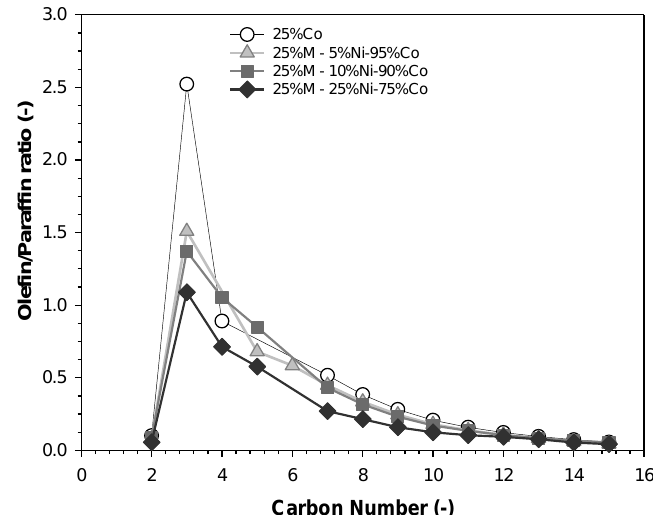
Figure 22. Olefin / para ffi n ratio at T.o.S. ≈ 150 h (process conditions: P = 20.6 bar, H 2 / CO = 2 mol / mol, Figure 22. Olefin/paraffin ratio at T.o.S. ≈ 150 h (process conditions: P = 20.6 bar, H 2 /CO = 2 mol/mol, T = 220 ◦ C, S.V. = 3.4 slph per g cat T = 220 ° C, S.V. = 3.4 slph per g cat ).